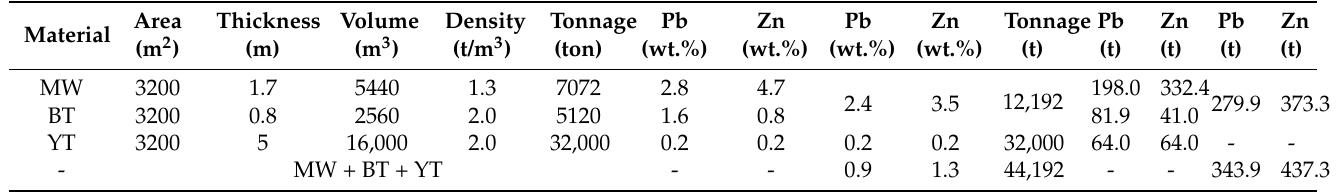
Figure 12. A 3D model of the distribution of the cover and tailings material at the Plombi è res site based on drill core logging and the geophysical profiles. Blue triangles represent drill hole locations, and green triangles represent the locations where both a pit-hole and a drill hole samples were taken. Table 3. Theoretical tonnages and metals content in the Plombi è res tailings pond. MW—metallurgical waste; BT—brown tailings; YT—yellow